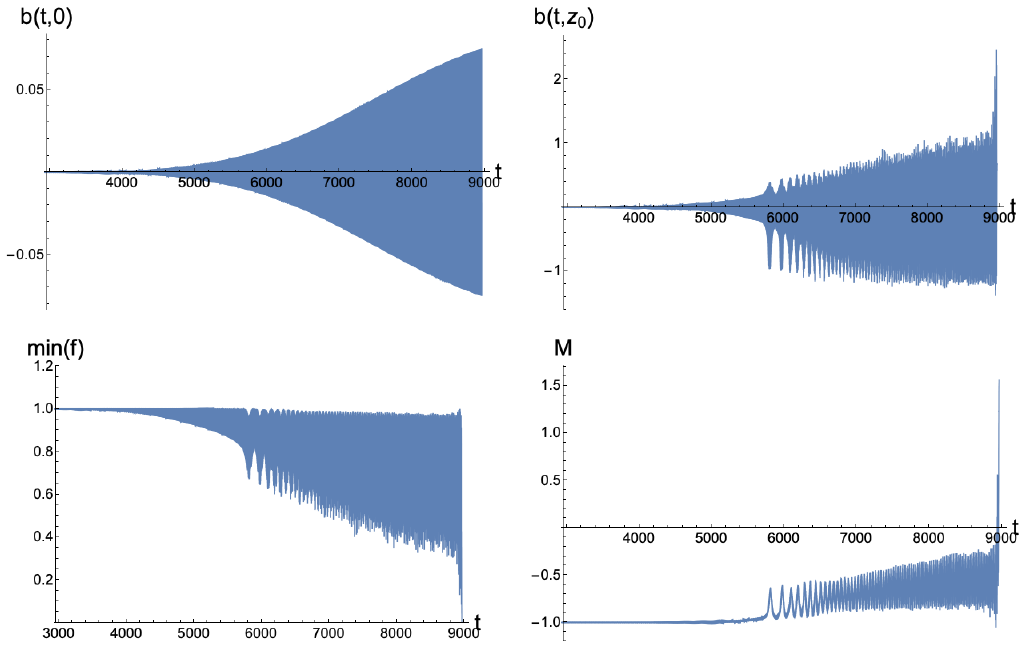
Numerical simulation of a quasi-static build-up protocol with ! = 2 : 375 and a time span (cid:12) = 1 : 5 (cid:2) 10 4 (see green dotted line in (cid:12)gure 6). All magnitudes evolve smoothly until an abrupt change is observed at t (cid:25) 5800 with b 0 (cid:25) 0 : 013. This transition signals the coupling to higher normal modes. The momentum constraint is always satis(cid:12)ed within one part in 10 (cid:0) 4 .